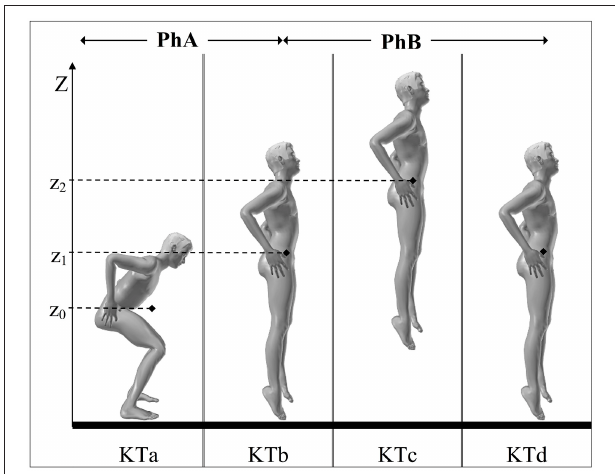
FIGURE 2 | Modeling the jump. The model consists of four segments: (cid:13) 1 , (cid:13) 2 , (cid:13) 3 , and (cid:13) 4 (respectively feet, legs, thighs, and head-arms-trunk). Other constituent elements are: the rotation axes orthogonal to (OX, OZ) ( ⊗ ), the segmental angles θ i and the segmental mass centers MCi ( (cid:7)